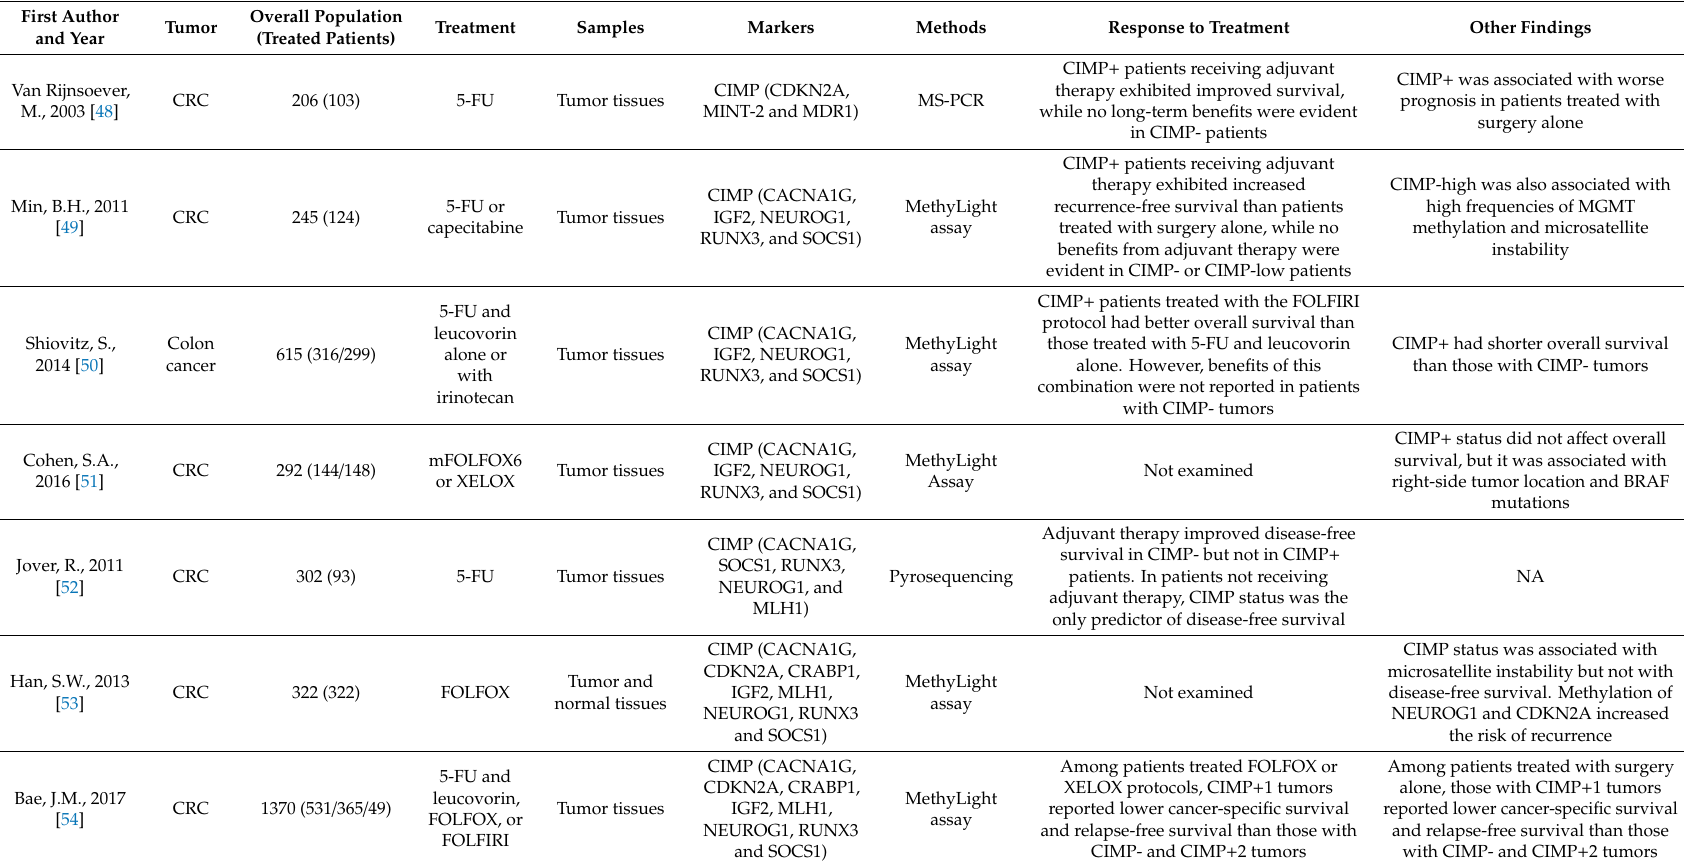
Table 2. CpG island methylator phenotype markers in patients receiving adjuvant